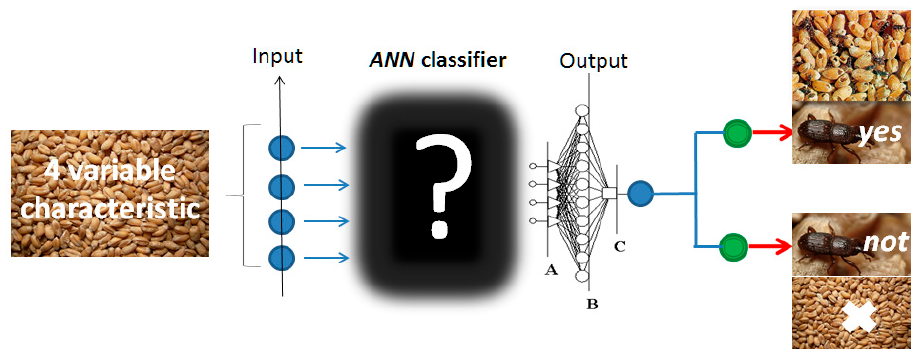
Figure 4. The structure of the generated ANN (Artificial Neural Network) type radial basis function (RBF).